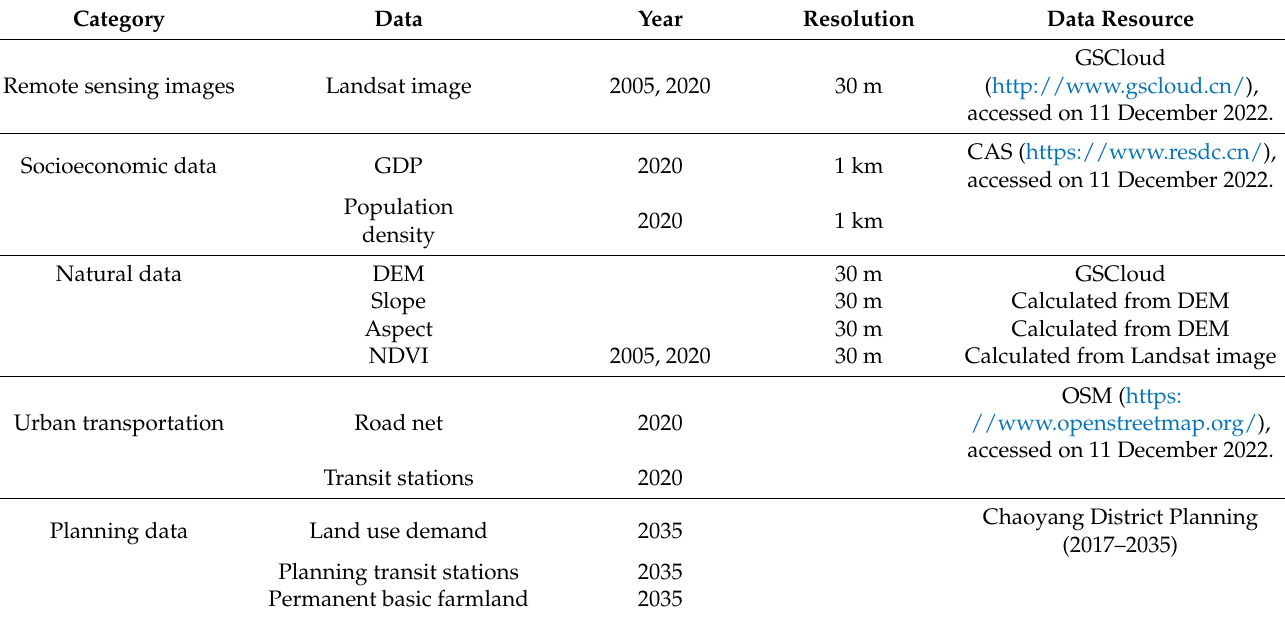
Table 1. List of data used in this study and their